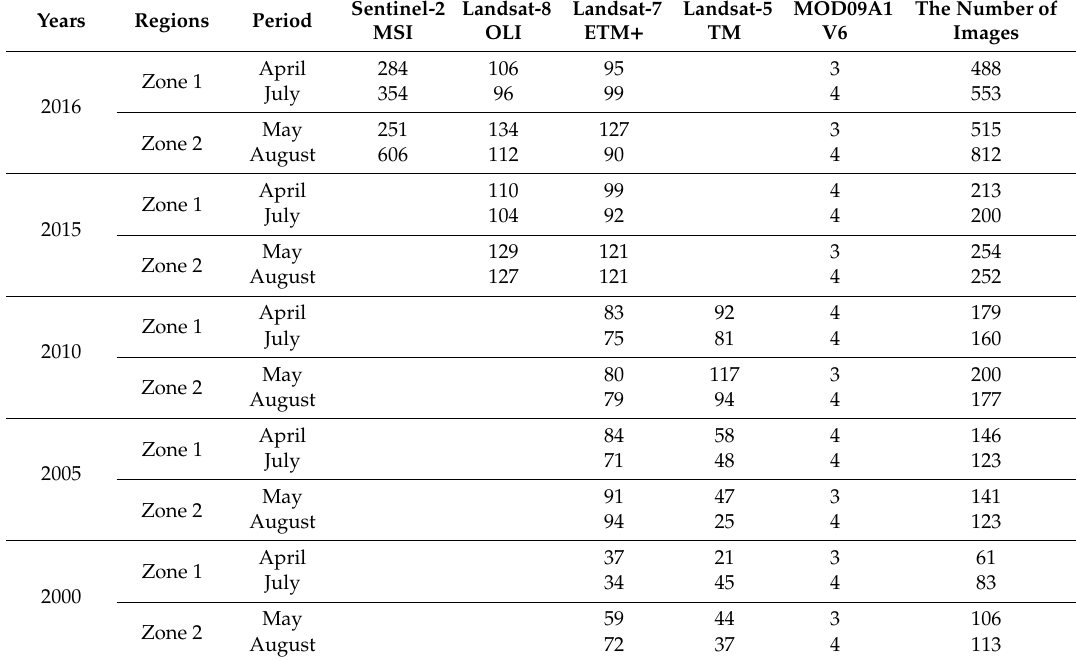
Table 3. The number of images used for mapping plastic-mulched farmland (PMF) in this study.